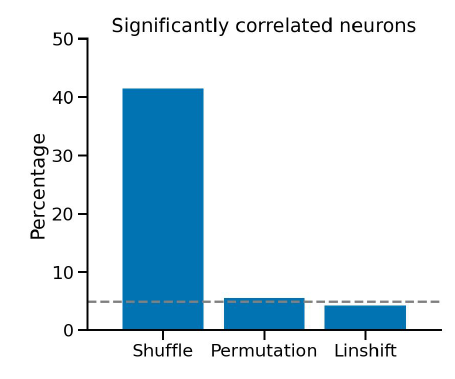
Figure 2 – Methods to correct for nonsense correlations. Shuffle : shuffling the cryptocurrency price traces to determine significance did not reduce the false positive rate to the desired level of 5%. Permutation : constructing a null-distribution of correlations using 1000 price traces from other time points worked well to bring the false positive rate down to 5%. Linshift : using the linear shift method whereby a ∼ window of time points is shifted through the session to generate a null-distribution also reduced the amount of significantly correlated neurons to the desired